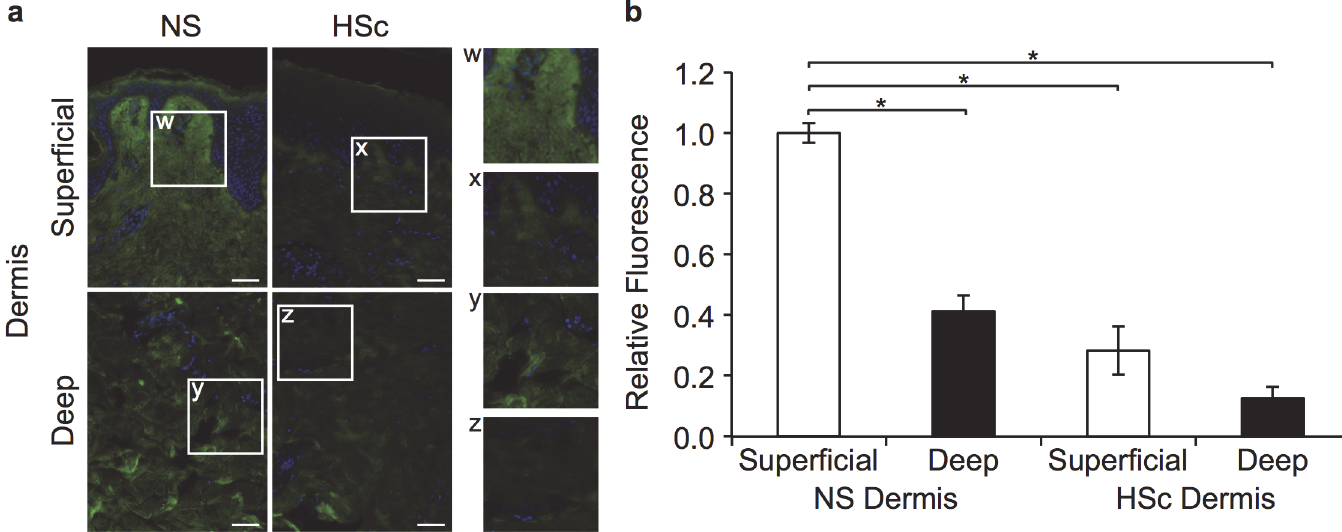
Fig 1. Immunohistochemical DCN expression in HSc and site-matched NS from burn patients. (a) Immunohistochemistry using a polyclonal goat anti- human DCN antibody and Alexa Fluor 488 secondary antibody (green fluorescence), and counterstained with DAPI (blue fluorescence) in representative site-matched sections of NS and HSc (scale bar = 50 μ m). (b) Relative expression of DCN in matched superficial and deep NS and HSc sections was calculated from fluorescence using ImageJ (mean ± SEM, n = 4 patients, * P < 0.001).